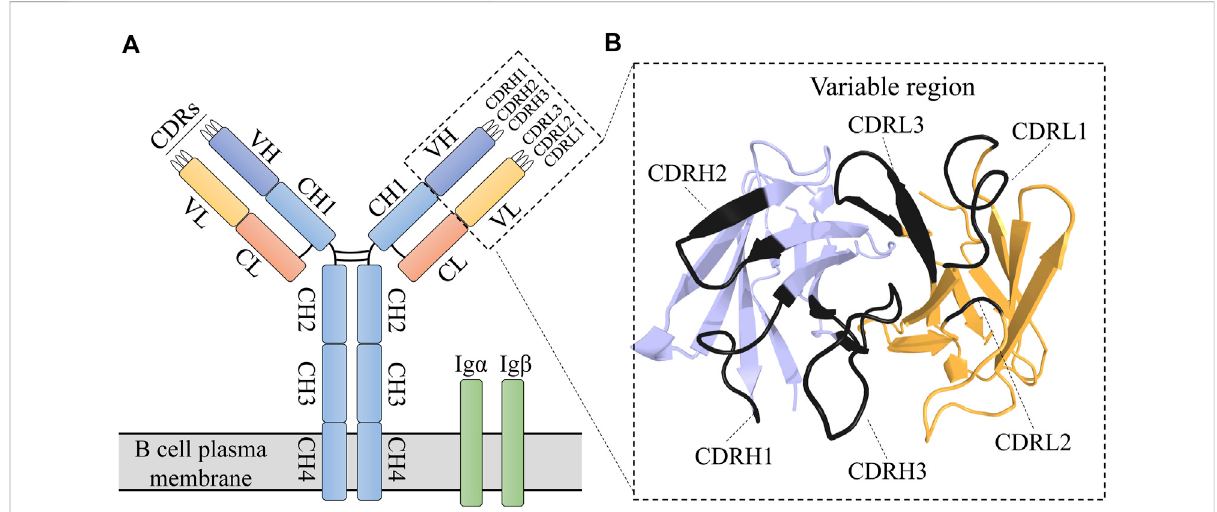
FIGURE 1 BCR structure. (A) Schematic representation of BCR structure. A BCR is composed of an immunoglobulin (antibody) molecule and a heterodimer (Ig α /Ig β ) that contain transmembrane and signal transduction regions. (B) The immunoglobulin variable region is composed of heavy (blue) and light (orange) chains (PDB entry: 7jmpHL). The six CDRs are represented by darker